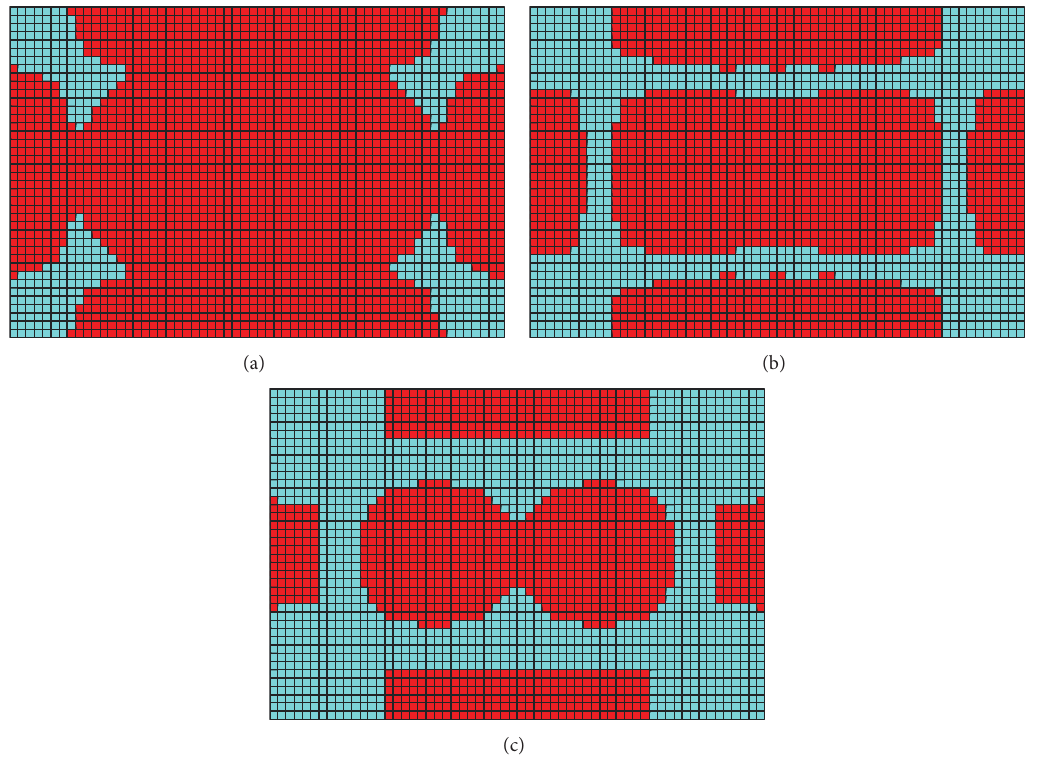
Figure 10: Topology evolving process using conventional sensitivity analysis. (a) Iteration 14 (rejection ratio 17.5%). (b) Iteration 28 (rejection ratio 35%). (c) Iteration 40 (rejection ratio 50%).